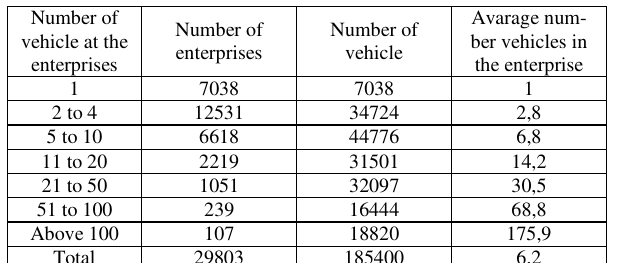
Table 2. Number of enterprises and trucks in the international transport in Poland arranged by the size of enterprises (as at the end of 2015) [4] Number of vehicle at the